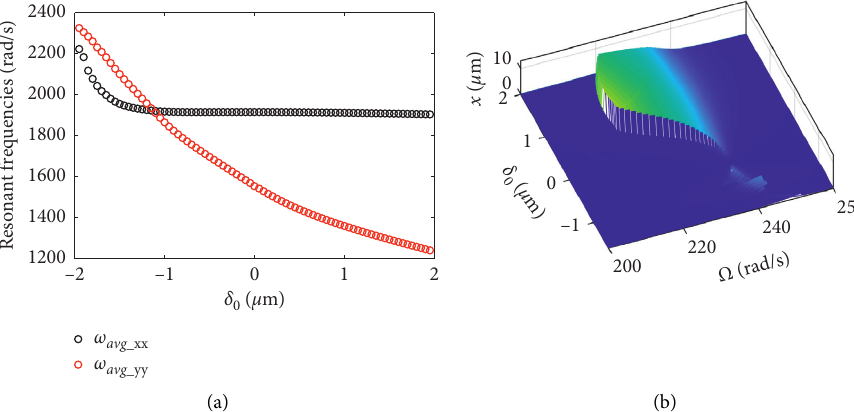
Figure 13: The system of (a) equivalent dynamic resonant frequencies and (b) waterfall plot of peak-to-peak x displacement for c � 200Ns/ m when Ω is sweeping up and down.